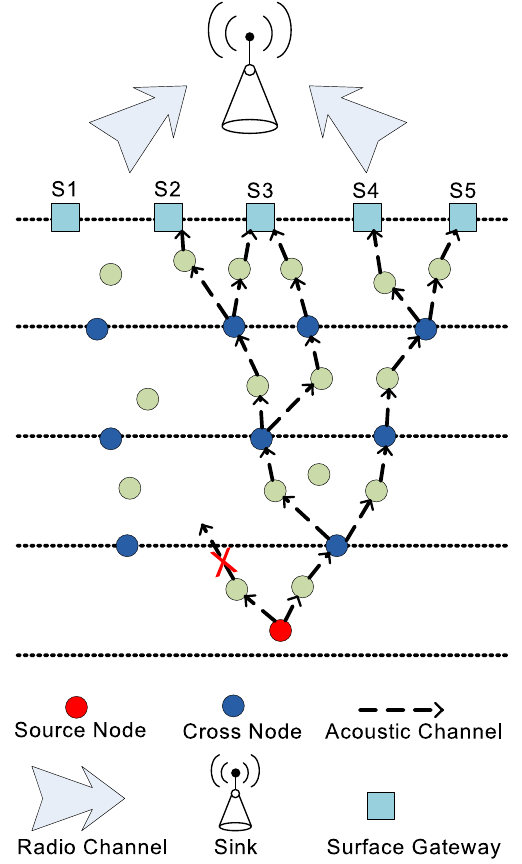
Figure 1. Network Architecture of layered multipath power control